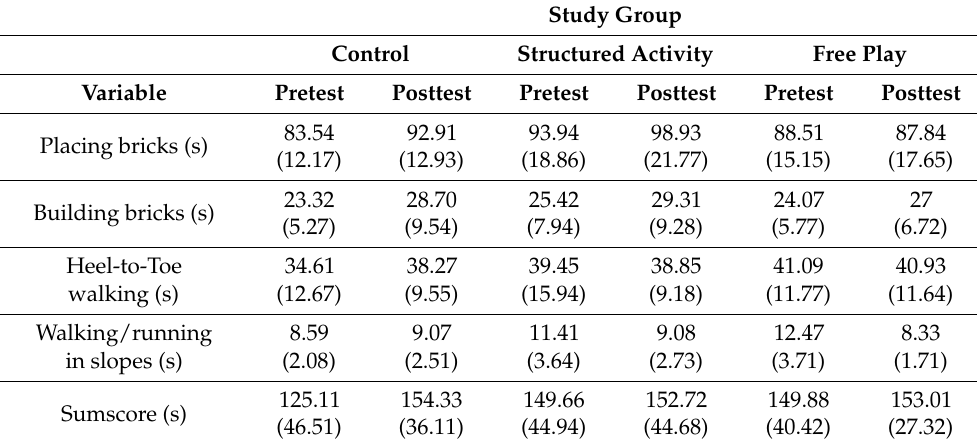
Table 1. Results (means, SD) from Test of Motor Competence (TMC) at pretest and posttest across study groups.